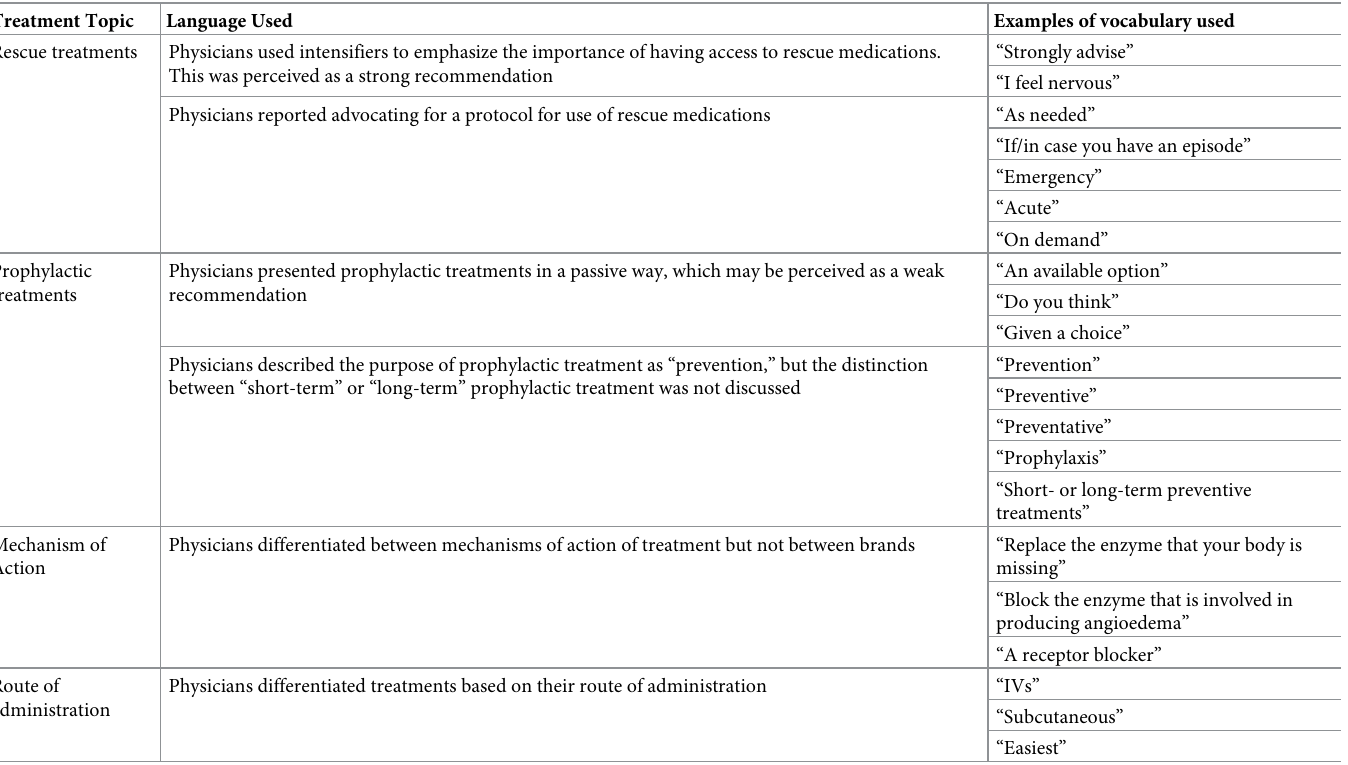
Table 2. Lexicon used by physicians to describe and recommend HAE